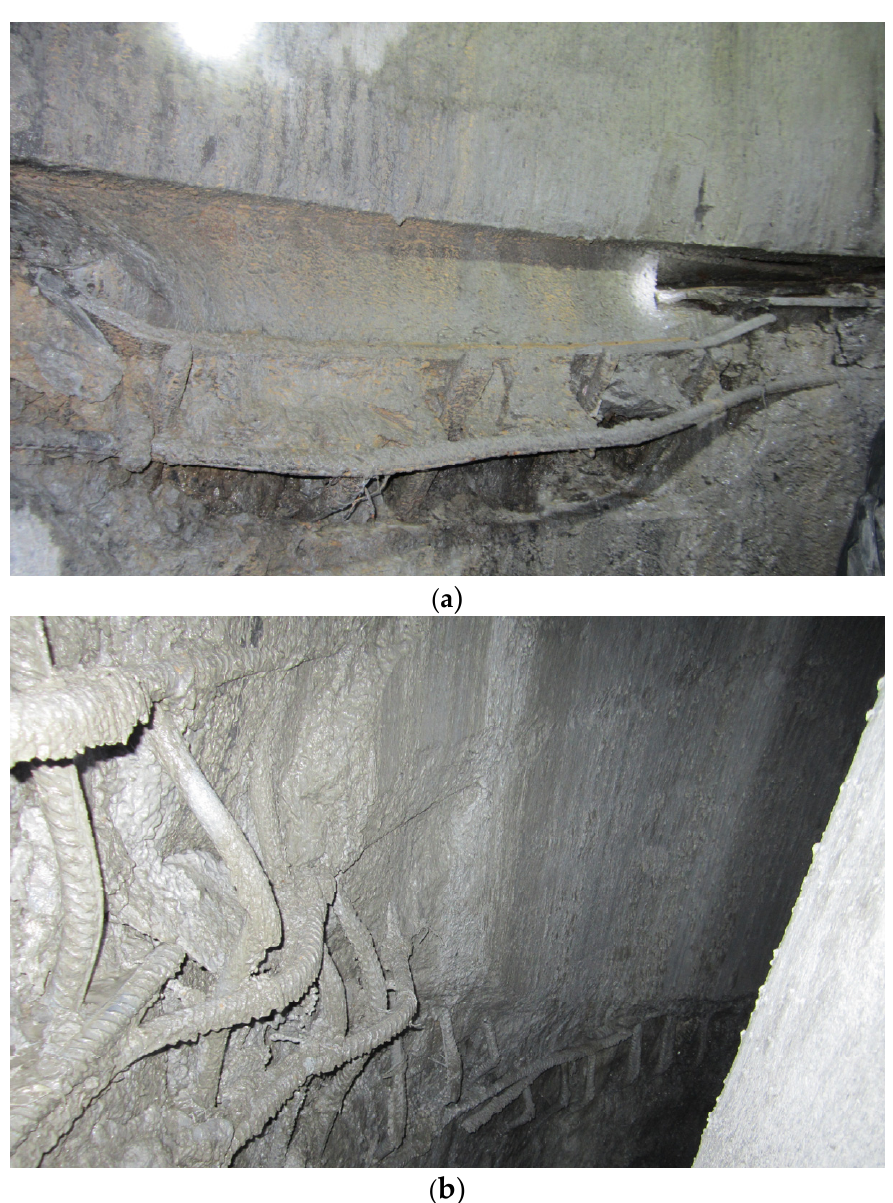
Figure 4. The photograph appearance of the damaged wall of the east ventilation shaft: ( a ) − 199.5 m, ( b ) − 339.5 m.